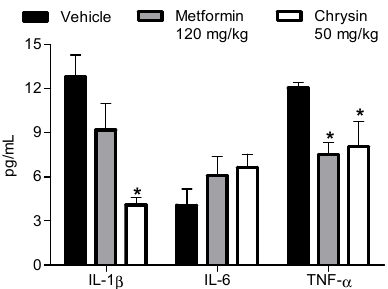
Figure 3. Effect of chrysin (50 mg/kg) on blood pro-inflammatory cytokines profile after ten days of treatment in streptozotocin–nicotinamide diabetic nude mice. Each plot represents the means ± SEM, n = 8; * p < 0.05.